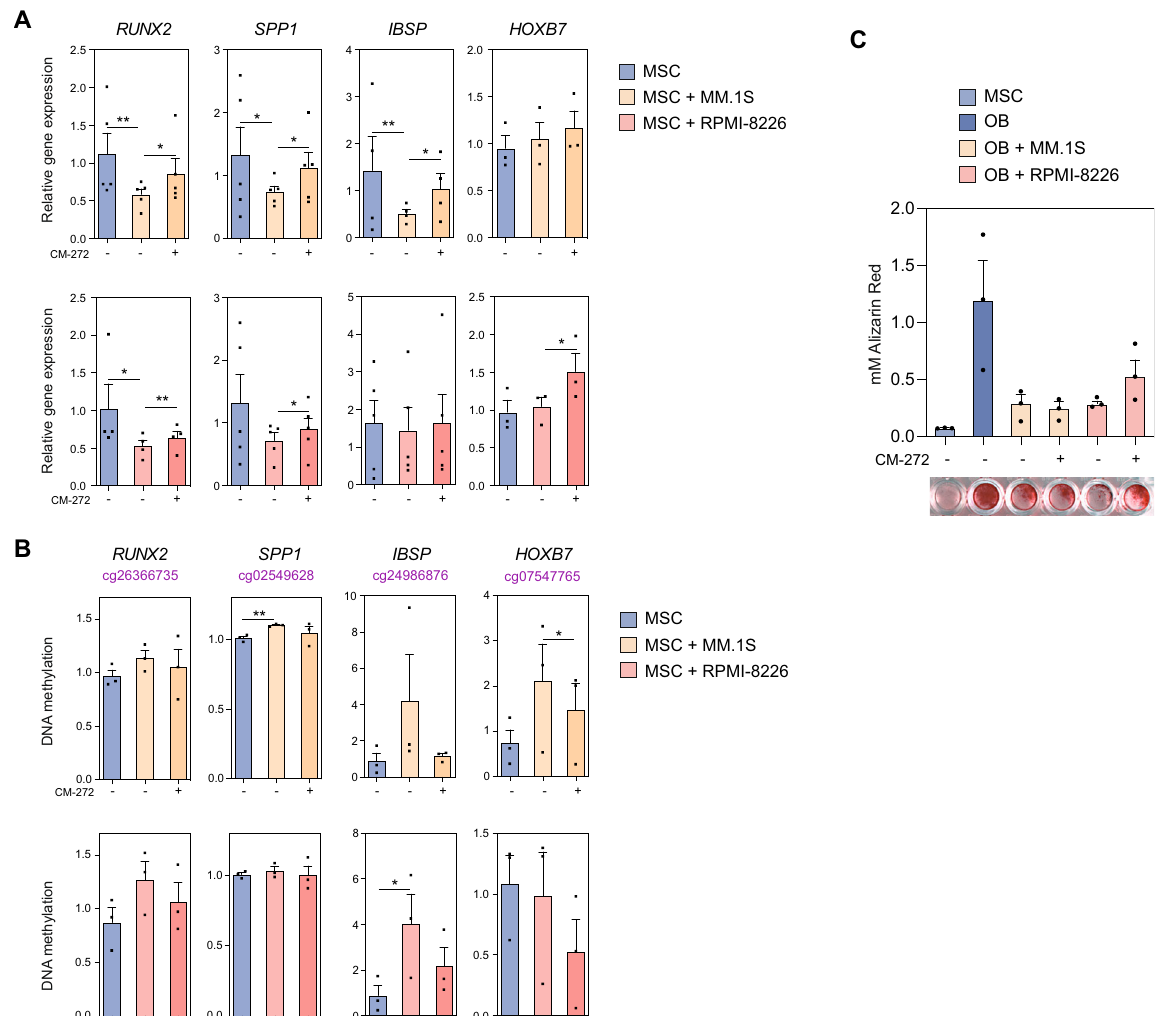
Fig. 5 CM-272 restores the gene expression levels and suppression of mineralization in MSCs from healthy donors exposed to MM cells. HD-MSCs (MSC; blue) were co-cultured with MM.1S (orange) or RPMI-8226 (red) cell lines separated by a transwell system in the presence (darker shade) or absence (lighter shade) of CM-272. A Relative expression and B DNA methylation of genes RUNX2 , SPP1 , IBSP, and HOXB7 was assessed. Gene expression was by normalization against RPL38 . Bar plots represent mean ± SEM of 3 – 5 independent experiments and statistical signi fi cance was calculated by paired one-tailed Student ’ s t -test (* p < 0.05, ** p < 0.01). C Mineralization was assessed by alizarin red staining in differentiated OBs from HD-MSCs co-cultured with MM.1S or RPMI-8226 cell lines in the presence or absence of CM-272. Representative micrographs show matrix mineralization by alizarin red staining of corresponding differentiated OBs. Data are represented as the mean ± SEM from three independent experiments and paired two-tailed Student ’ s t -tests were performed (* p < 0.05, ** p < Bisul fi te pyrosequencing . For total DNA extraction, cells were lysed using lysis protein L38 ( RPL38 ) used for normalization. Relative quanti fi cation of the target gene expression was calculated by the comparative threshold cycle (Ct) method. buffer (50 mM Tris pH 8.8, 10 mM EDTA pH 8.3, 100 mM NaCl, 1% SDS) in the presence of Proteinase K (Roche). Repeated centrifugation was performed to separate nucleic acids from lipids, in which DNA was subsequently precipitated using isopropanol and washed with 75 % ethanol. 100-300 ng of isolated DNA were Co-culture system and MSC sorting . MSCs from healthy donors at passage 3 (8 × bisul fi te (BS)-converted using EZ DNA Methylation-Gold ™ Kit (Zymo Research, 10 3 cells/cm 2 ) or the hMSC-TERT cell line (10 × 10 3 cells/cm 2 ) were fi rst cultured CA, USA) according to manufacturers ’ instructions. BS-converted DNA (~10ng) was used as a template for ampli fi cation by conventional PCR using IMMOLA- SE TM DNA Polymerase kit (Bioline, London, UK). PCR primers were designed with the PyroMark Assay Design v2.0.2 software (Qiagen). PCR products were pyrosequenced with the PyromarkTM Q24 system (Qiagen), according to the manufacturer ’ s protocol.